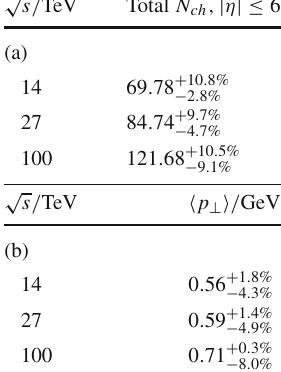
Table 6 Table showing the NLO inclusive jet cross section for (a) p ⊥ j ≥ 50 GeV and (b) p ⊥ j ≥ 100 GeV, as predicted by